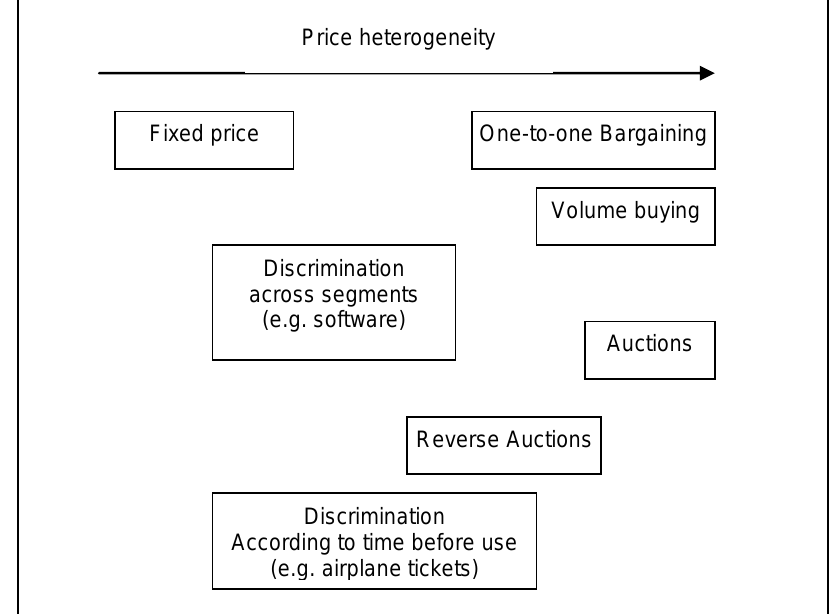
Figure 1: Level of Price